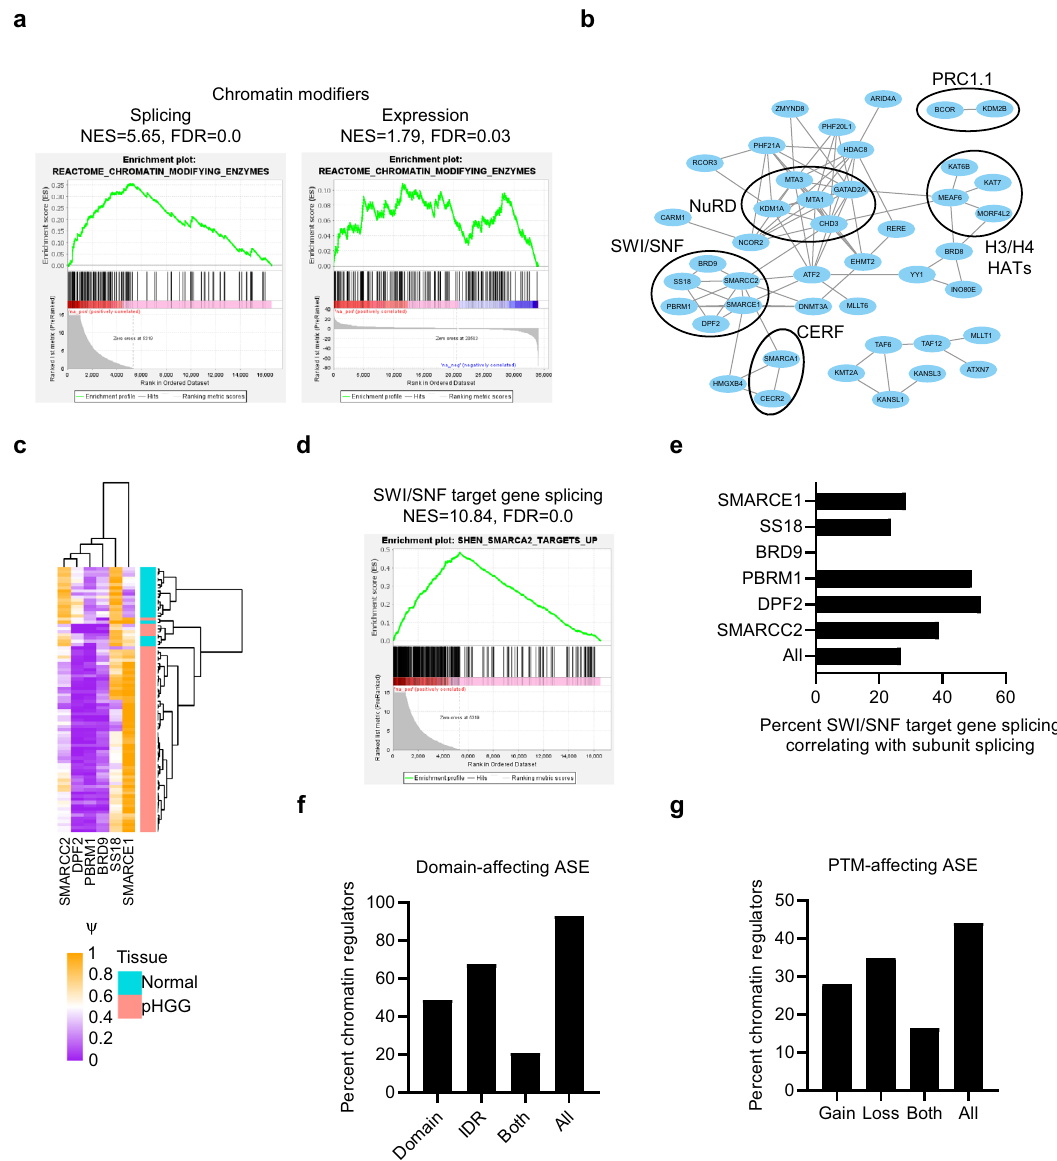
Fig. 3 Chromatin regulators are disrupted by alternative splicing in pHGG. a Gene set enrichment analysis of chromatin-modifying enzymes among genes differentially spliced (left) or differentially expressed (right) in pHGG. NES normalized enrichment score, FDR false discovery rate. b Protein – protein interactions between chromatin-related proteins that are differentially spliced in pHGG were retrieved from STRING. Edge thickness represents interaction con fi dence. SWI/SNF mammalian switch/sucrose-nonfermentable, NuRD nucleosome remodeling and deacetylase, PRC1.1 polycomb-repressive complex 1.1, CERF CECR2-containing remodeling factor complex. c Heatmap of percent inclusion ( ψ ) of differential splicing events (| Δψ | >0.15, FDR < 0.05) identi fi ed between pHGG ( n = 64) and normal brain ( n = 20) in SWI/SNF complex members. d Gene set enrichment analysis (GSEA) of SWI/SNF target gene enrichment among genes differentially spliced in pHGG. NES normalized enrichment score, FDR false discovery rate. e Proportion of SWI/SNF target genes whose ψ correlates signi fi cantly (Benjamini – Hochberg corrected P < 0.05) with ψ of each SWI/SNF complex member across pHGG samples ( n = 64), or with the maximally variant complex member ( “ All ” ) in each sample. f Percentage of chromatin regulators with differential ASE predicted to affect structural domains and intrinsically disordered domains (IDR) mapped in UniProt. g Percentage of chromatin regulators with differential ASE predicted to affect post-translational modi fi cation (PTM) sites mapped in UniProt. Statistical tests: t test with Benjamini – Hochberg multiple hypothesis testing correction ( e ). Source data are provided as a Source Data fi